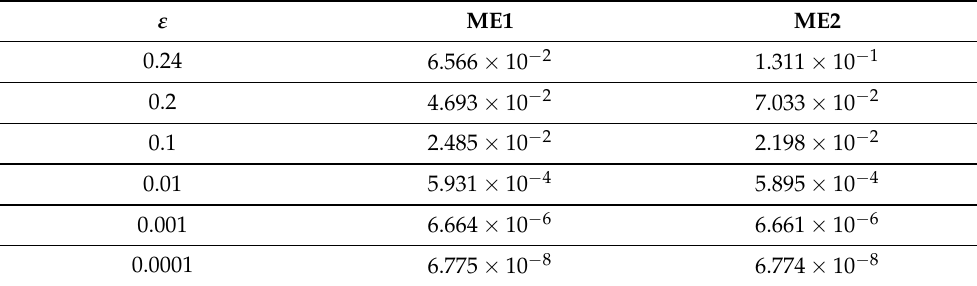
Table 1. Comparing ME1 and ME2 obtained from the present solution and the original asymptotic solution to the exact one with different ε